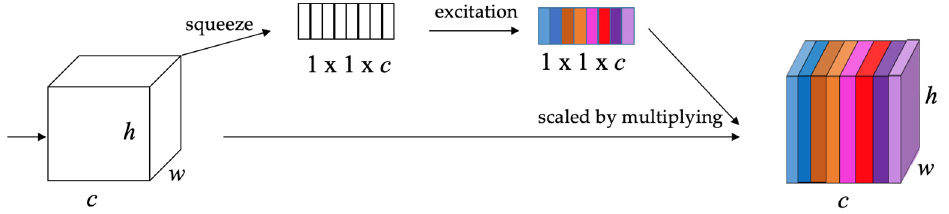
Figure 14. Squeeze-and-Excitation Networks [27].